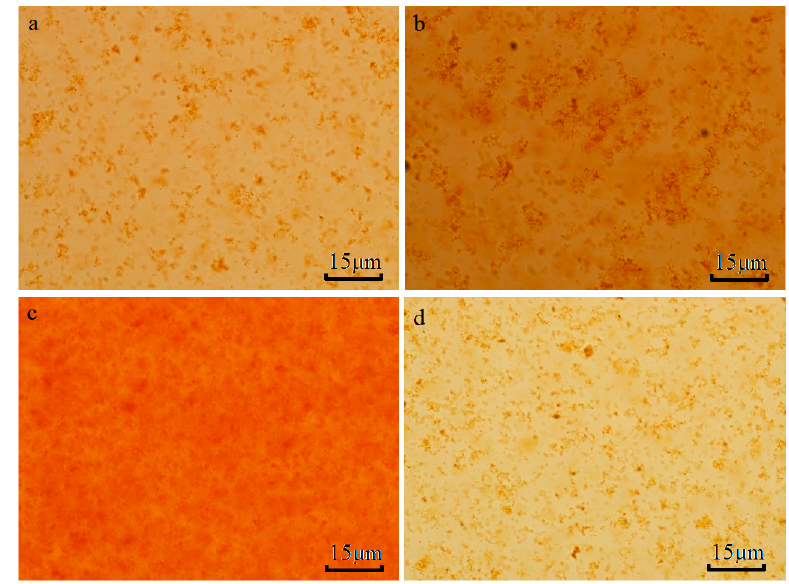
Figure 5. Floc image analysis ( a ) rapid mixer for 30 L/h; ( b ) flocculation basin for 30 L/h; ( c ) sedimentation tank for 30 L/h; ( d ) rapid mixer for 60 L/h.